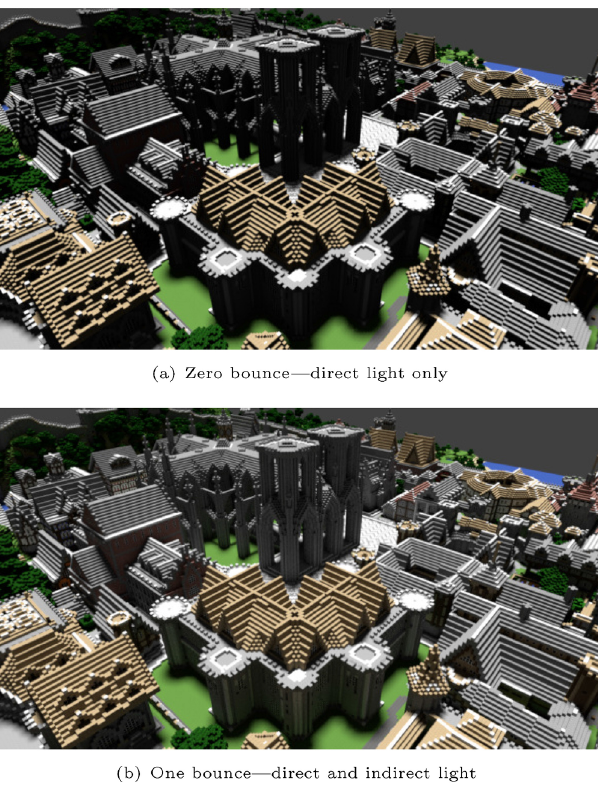
Fig. 7 Rungholt scene rendered using path tracing with zero and one